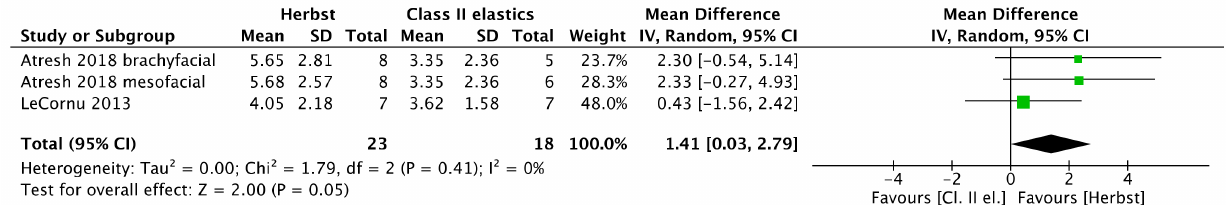
Figure 16. Forest plot of the left mandibular ramus height changes using the random effects model [43,44]. Significant differences favoring Herbst compared to Class II elastics were observed for right mandibular length (Co-Gn) (Figure 17) [mean difference (95% CI): 1.41 mm (0.03, 2.79), I 2 = 0%], left mandibular length (Co-Gn) (Figure 18) [mean difference (95% CI): 1.47 mm (0.16, 2.79), I 2 = 0%], and right mandibular ramus height (Co-Go’) (Figure 19) [mean difference (95% CI): 1.61 mm(0.43, 2.78), I 2 = 0%].